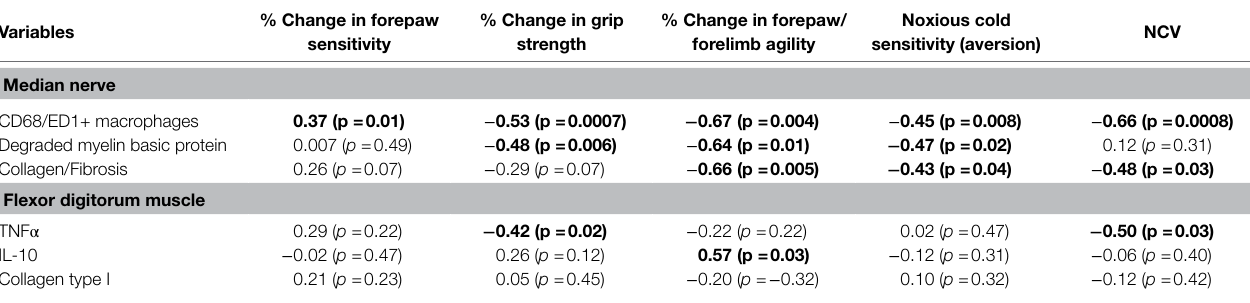
TABLE 2 | Spearman’s rank correlations between median nerve immunohistochemical and histological responses and functional outcomes. % Change in forepaw Variables